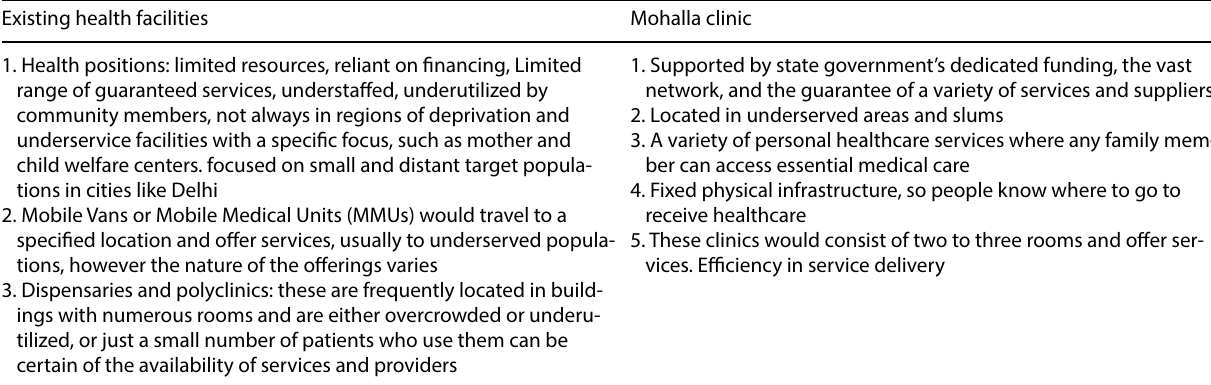
Table 1 Comparative analysis: Mohalla Clinic and existing infrastructure Existing health